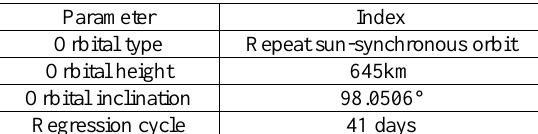
Table 1. Satellite orbit parameters